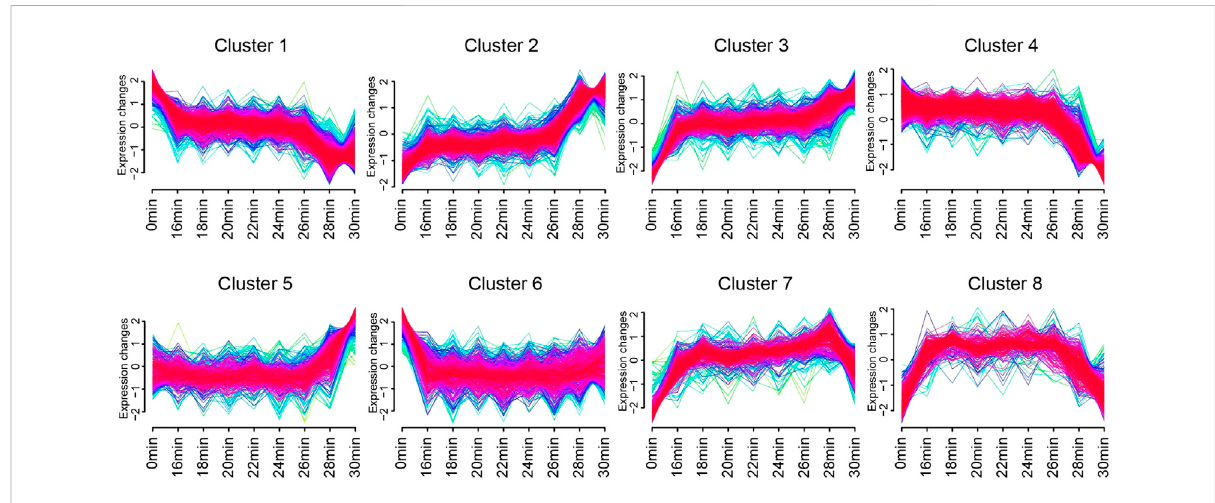
FIGURE 5 Thetime-dependentgeneexpressionpatternsofgenesinunionDEGsset.Eightclustersidenti fi edbasedongeneexpressionofgenesinunion DEGs set by Mfuzz R package. Curves in yellow or green denote genes with small membership values, while curves in red or purple correspond to genes with big membership